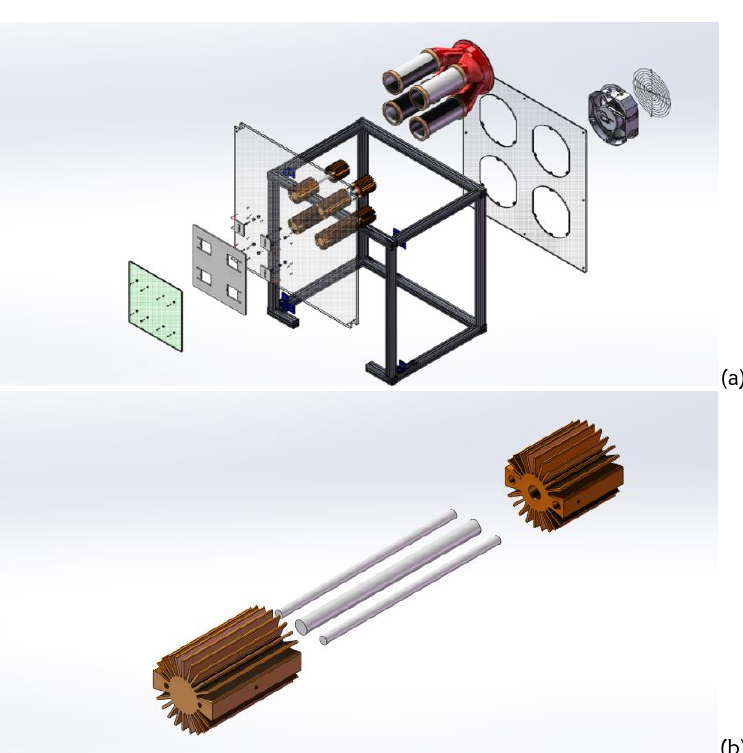
Figure 5: AWG Test Platform with Configurable Condensation Plate Assemblies (a) and Hybrid Heat Sink / Heat Pipe Cooling Assembly